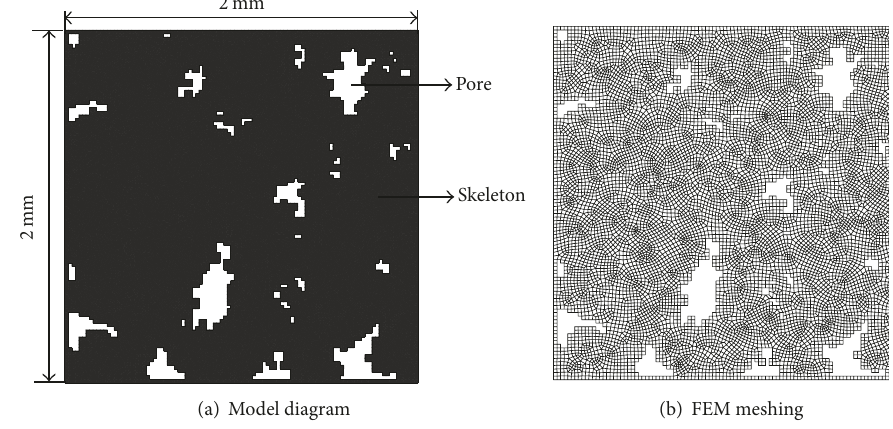
Figure 5: The model of the finite